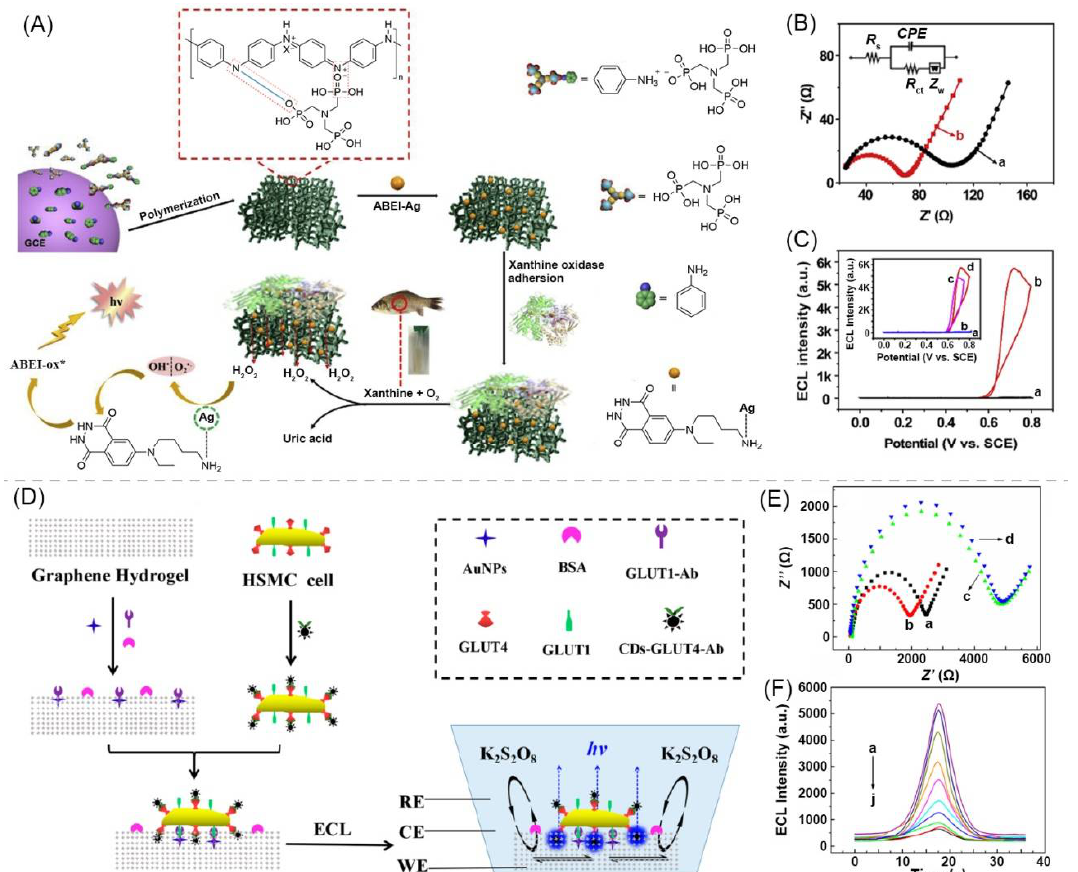
Figure 3. ( A ) Schematic of preparation process of PAni polymeric hydrogel-based ABEI–Ag@PAni–ATMP ECL biosensor for xanthine. ( B ) EIS of Ani-ATMP modified GCE (a) and PAni–ATMP modified GCE (b). ( C ) ECL-potential curve of 2019, Elsevier Ltd. ( D ) Schematic of fabrication process of graphene hydrogel-based ECL cytosensor. ( E ) EIS spectra of GH (a), GH/AuNPs (b), GH/AuNPs/GLUT1–Ab/BSA (c), and GH/AuNPs/GLUT1–Ab/BSA/cell@CDs–GLUT4–Ab (d). ( F ) ECL curves obtained with different recombinant GLUT4 concentrations (0 to 4.5 ng · mL − 1 from a to j). Adapted with permission [83]; copyright 2019, American Chemical